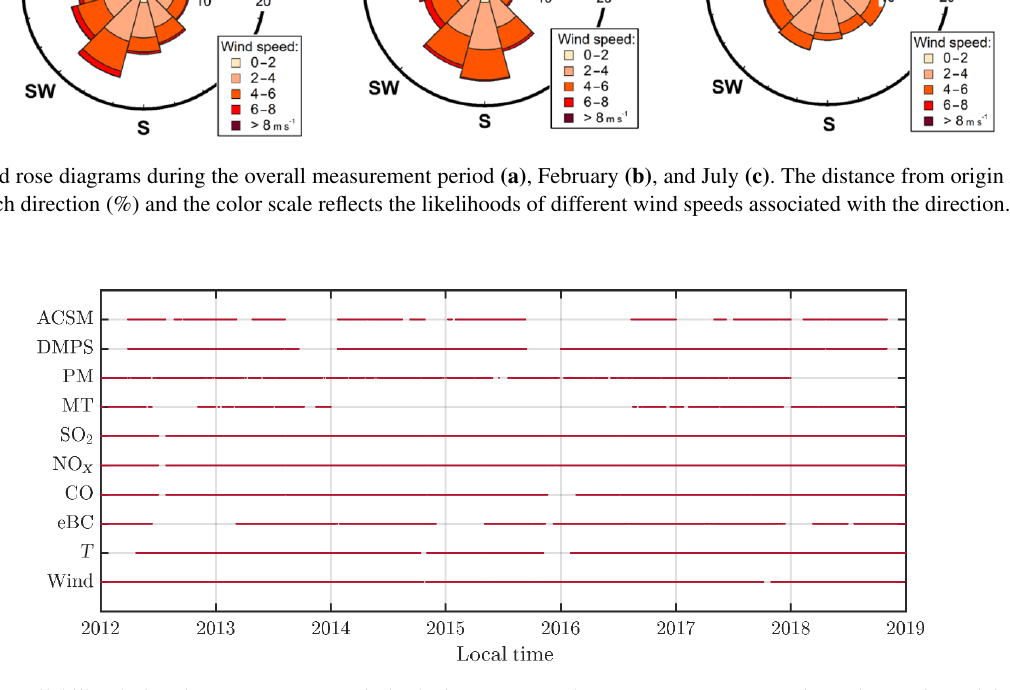
Figure A2. Data availability during the measurement period. The instrument and measurement parameter is on the y axis, and time is on the x axis. Gaps in the red line correspond to times when no data were available.